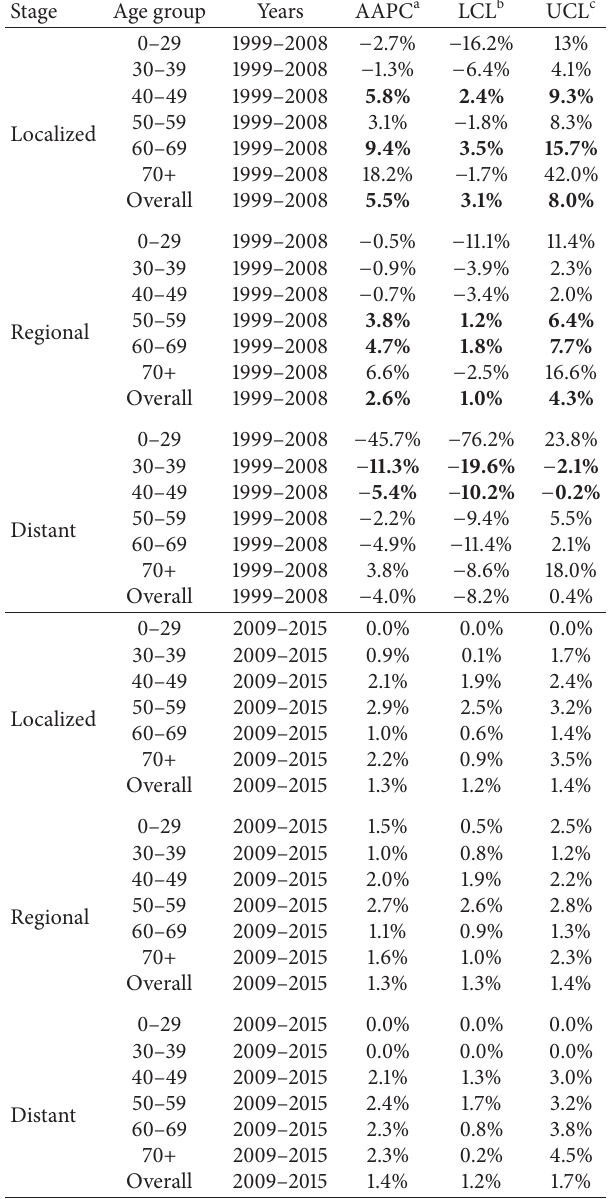
Table 3: Average annual percent change (AAPC) in breast cancer incidence rates/100,000 person-years by summary stage and age group and predictions for breast cancer caseloads, years